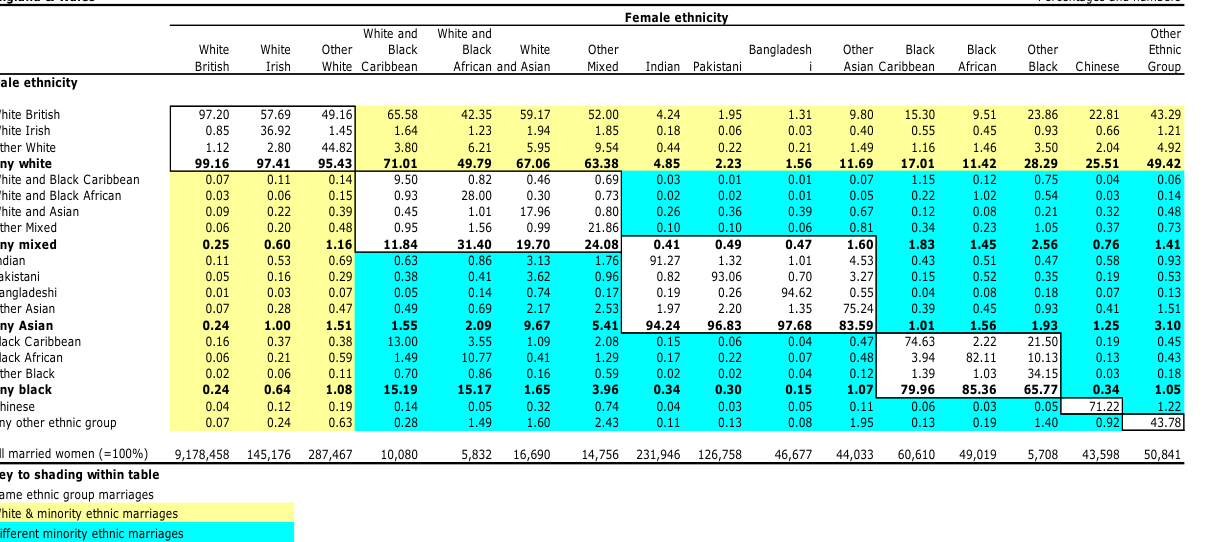
Figure 1. Percentage of women married to men by ethnic group, April 2001. Source: 2001 England and Wales Census. ONS, 2015. Note: An accompanying table is available for percentage of men married to women by ethnic group. Full matrices of unions by detailed ethnic and pan-ethnic ( racial ) group are available for the 2011 England and Wales Census. See: Office for National Statistics, 2014c.